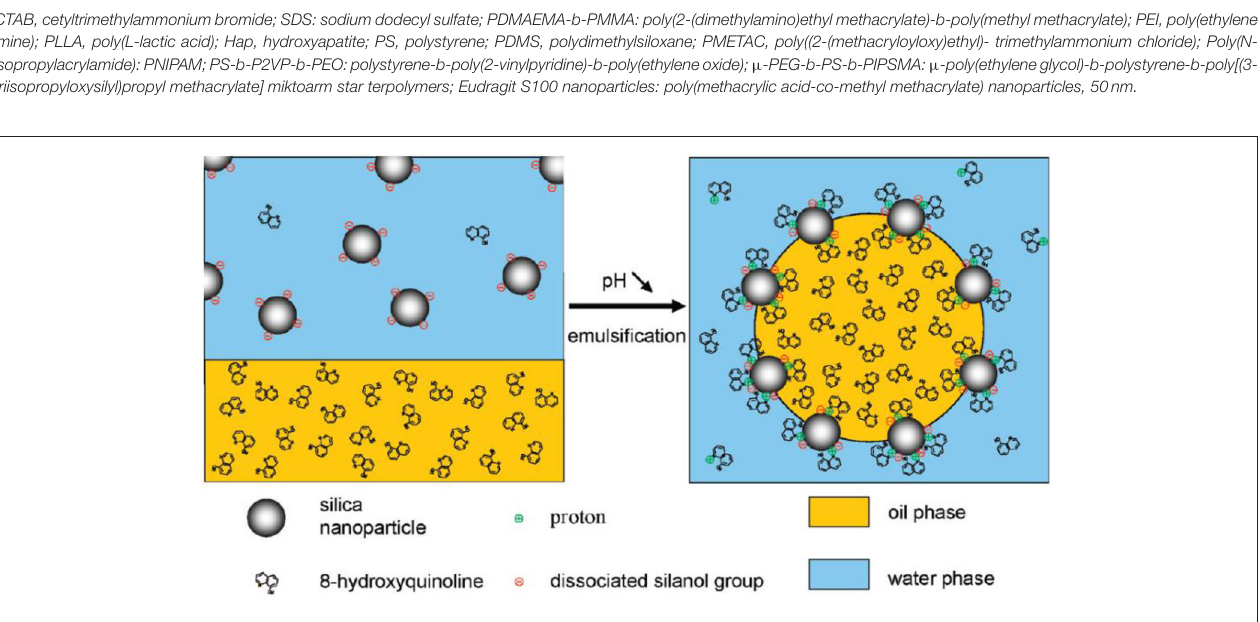
dodecanoate at high concentration, which endowed the particle surface hydrophilicity again and induced desorption of the particles from the interface. Consequently, the emulsion droplets were stabilized solely by the surfactants (Cui et al.,